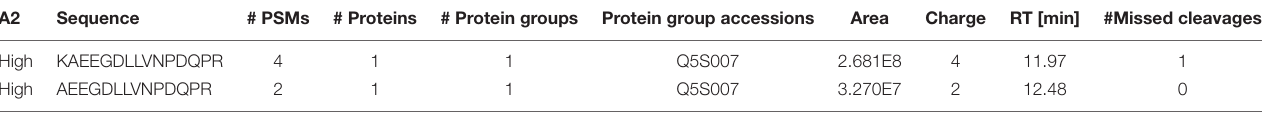
TABLE 2 | Peptide mapping results following N241A/34 immunoprecipitation of tryptic digested recombinant LRRK2. A2 Sequence # PSMs # Proteins # Protein groups Protein group accessions